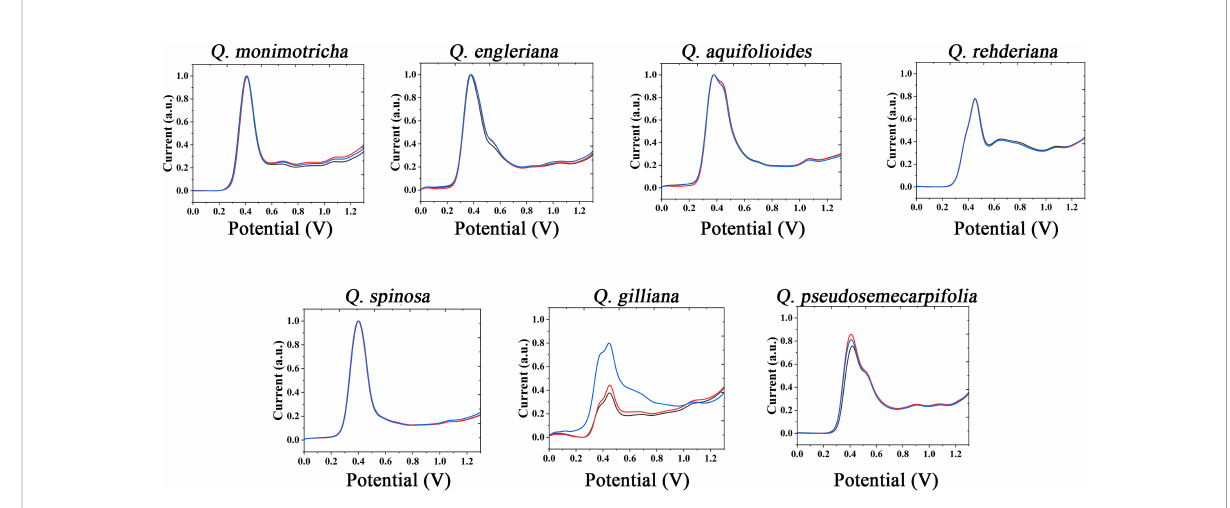
FIGURE 1 Electrochemical fi ngerprint of Q. monimotricha, Q. engleriana, Q. aquifolioides, Q. rehderiana, Q. spinosa, Q. gilliana and Q. pseudosemecarpifolia after water extraction and recorded under PBS condition with three repetitive